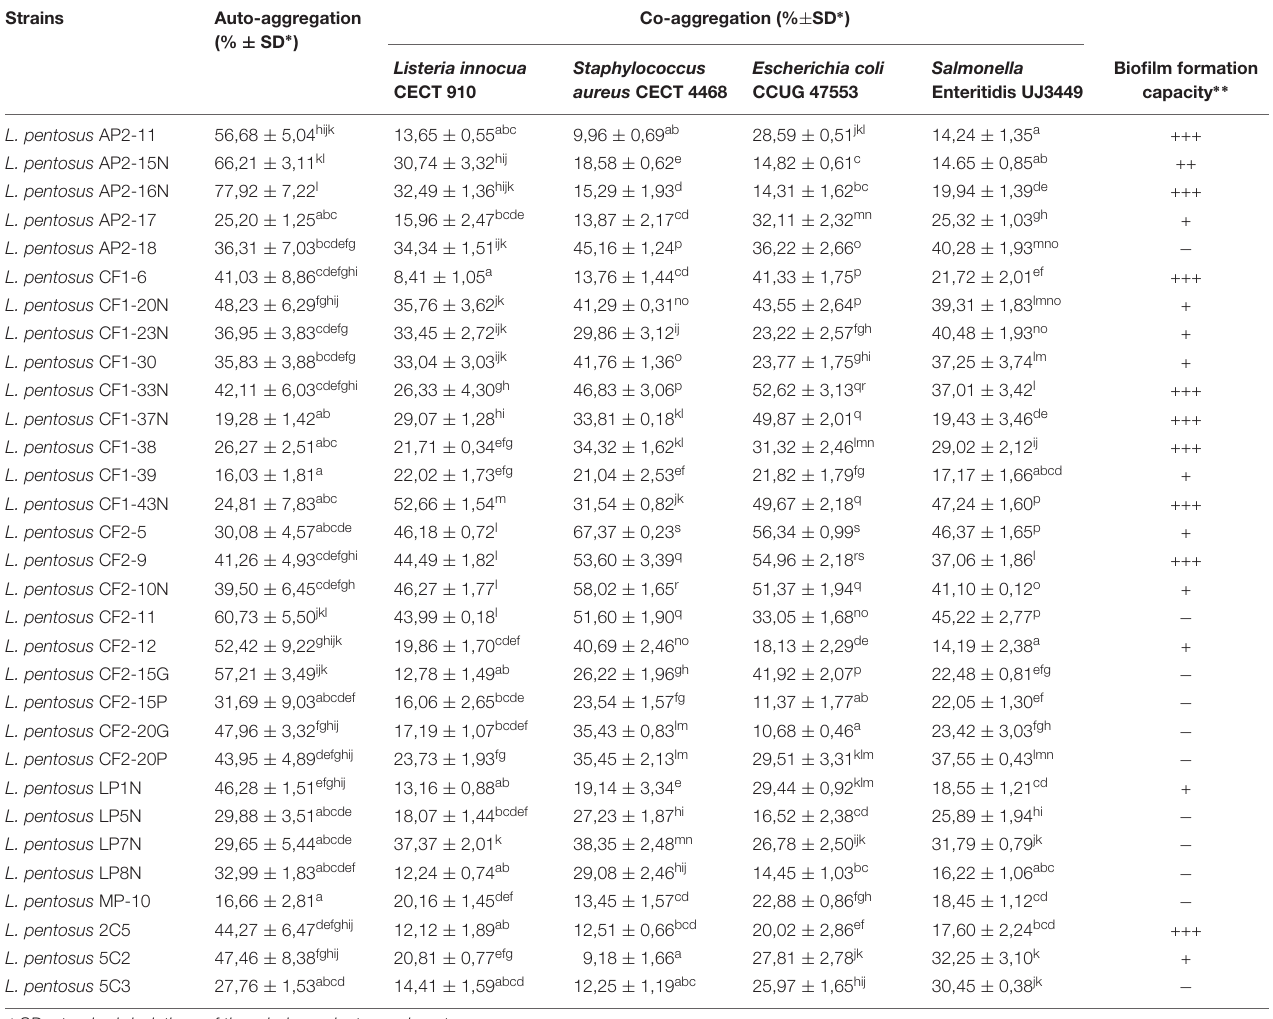
TABLE 2 | Auto-aggregation, co-aggregation, and biofilm formation abilities of Lactobacillus pentosus strains.